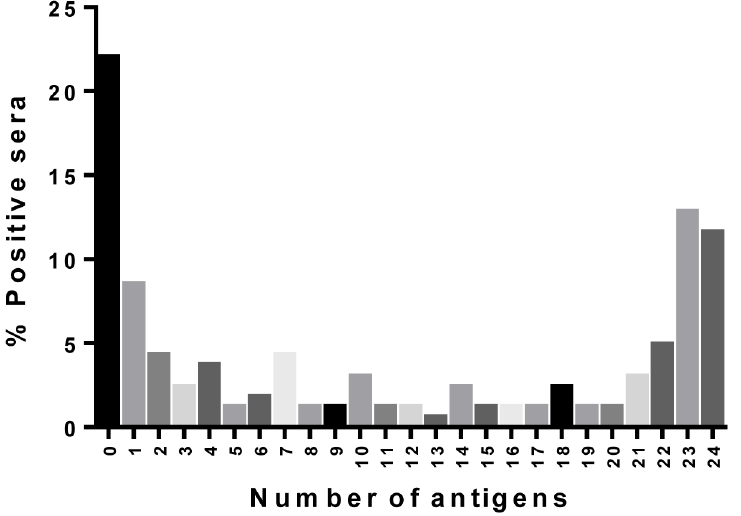
Fig 1. Positivity to different α -helical coiled coil peptides. Data are plotted as the percentage of individuals who are antibody positive for 0–24 of the antigens tested. vivax clinical risk (aIRR: 0.970, P < 0.001, 95% CI: 0.953–0.987). Finally, when multivariate analyses and backward stepwise regression were performed, only antibody levels to Pv95 (aIRR(multi) = 0.35, p < 0.001, 95% CI: 0.209, 0.604) remained significantly associated with a reduced risk of P . vivax clinical disease.